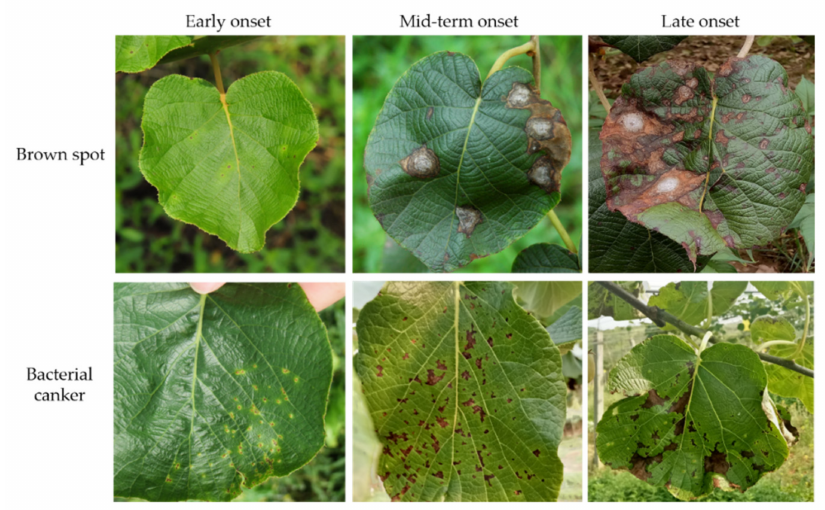
Figure 1. The original picture in the dataset.